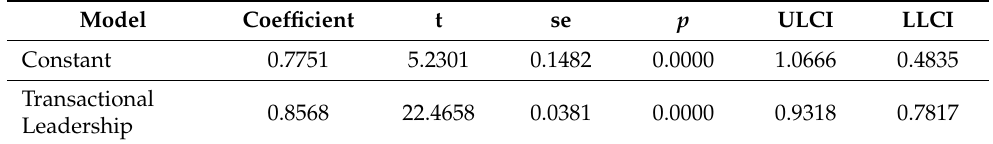
Table 12. Coefficients of Regression